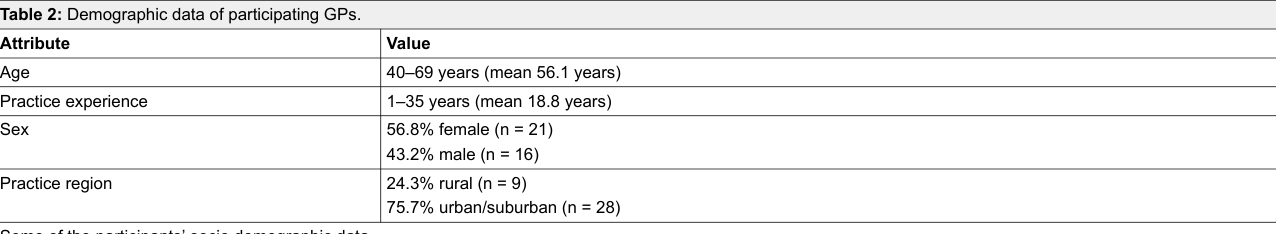
Table 2: Demographic data of participating GPs.